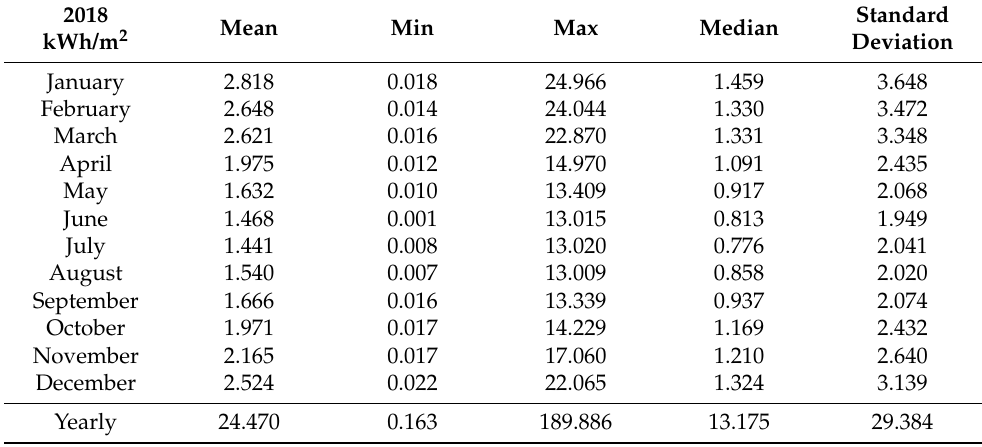
Figure 9. Monthly district heating demand and air temperature in Borlänge in 2018. Table 2. Electricity demand per month: averages, minimum, maximum and